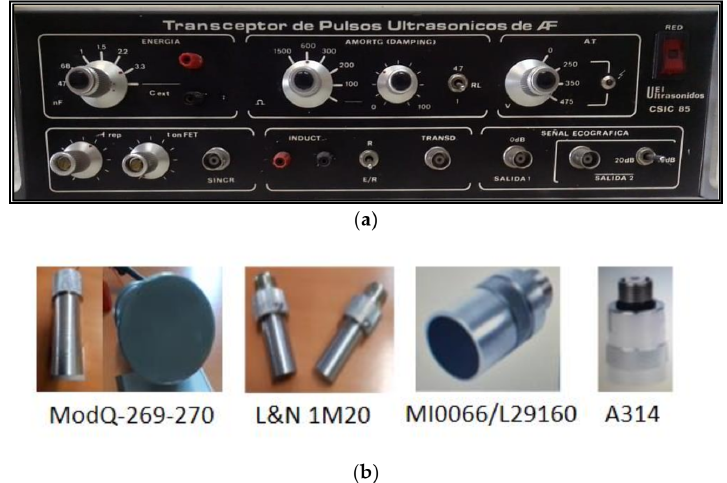
Figure 5. Our own-design reconfigurable HV electronic transceiver ( a ) and wideband piezoelectric transducers ( b ) that have been employed in the experimental works shown and analyzed